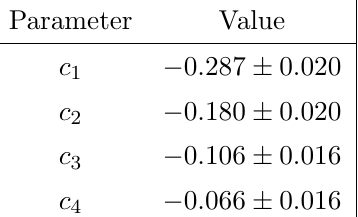
Table 7 . Parameters used in the nominal model for the scalar K(cid:25) mass-dependent amplitude. The correlations among them are found to be small, the largest ones been of the order of 50%.